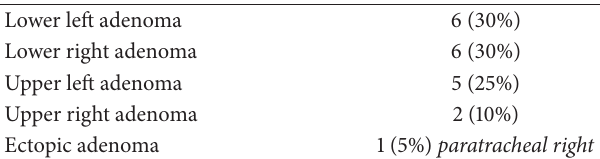
Table 3: Surgical findings.